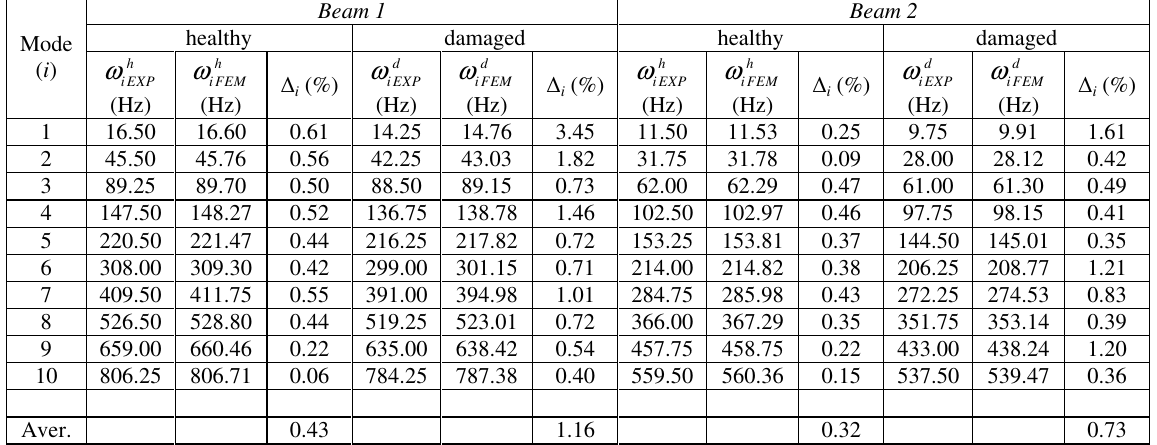
Table 1. Flexural frequencies and residuals for the Beam 1 and the Beam 2 with FF boundary